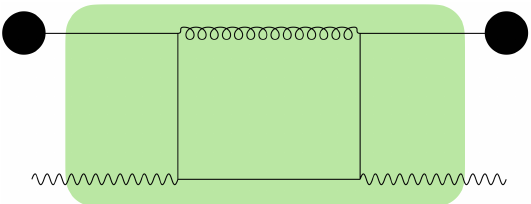
Figure 2: To build the coefficient functions, we focus on the partonic part of the forward scattering diagram, highlighted in green.